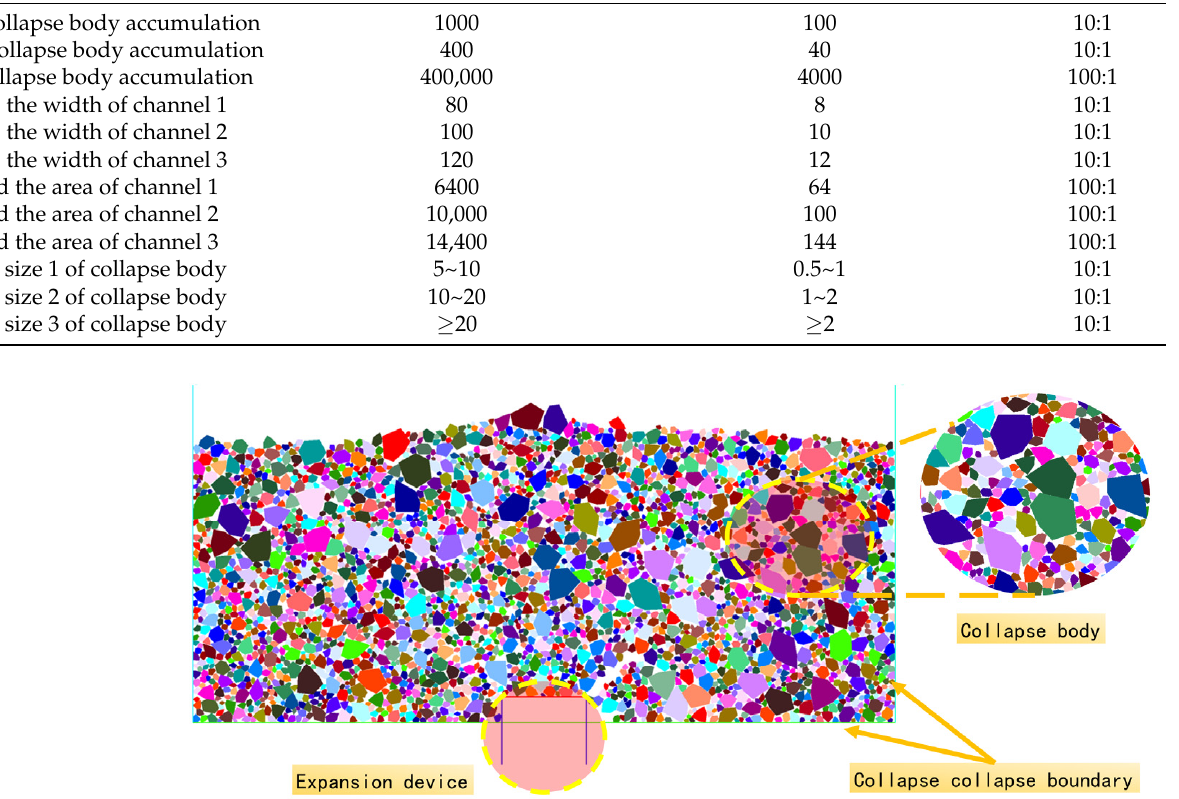
Table 2. Numerical model parameters.